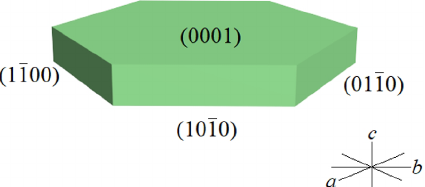
Figure 3. Ideal crystal form of